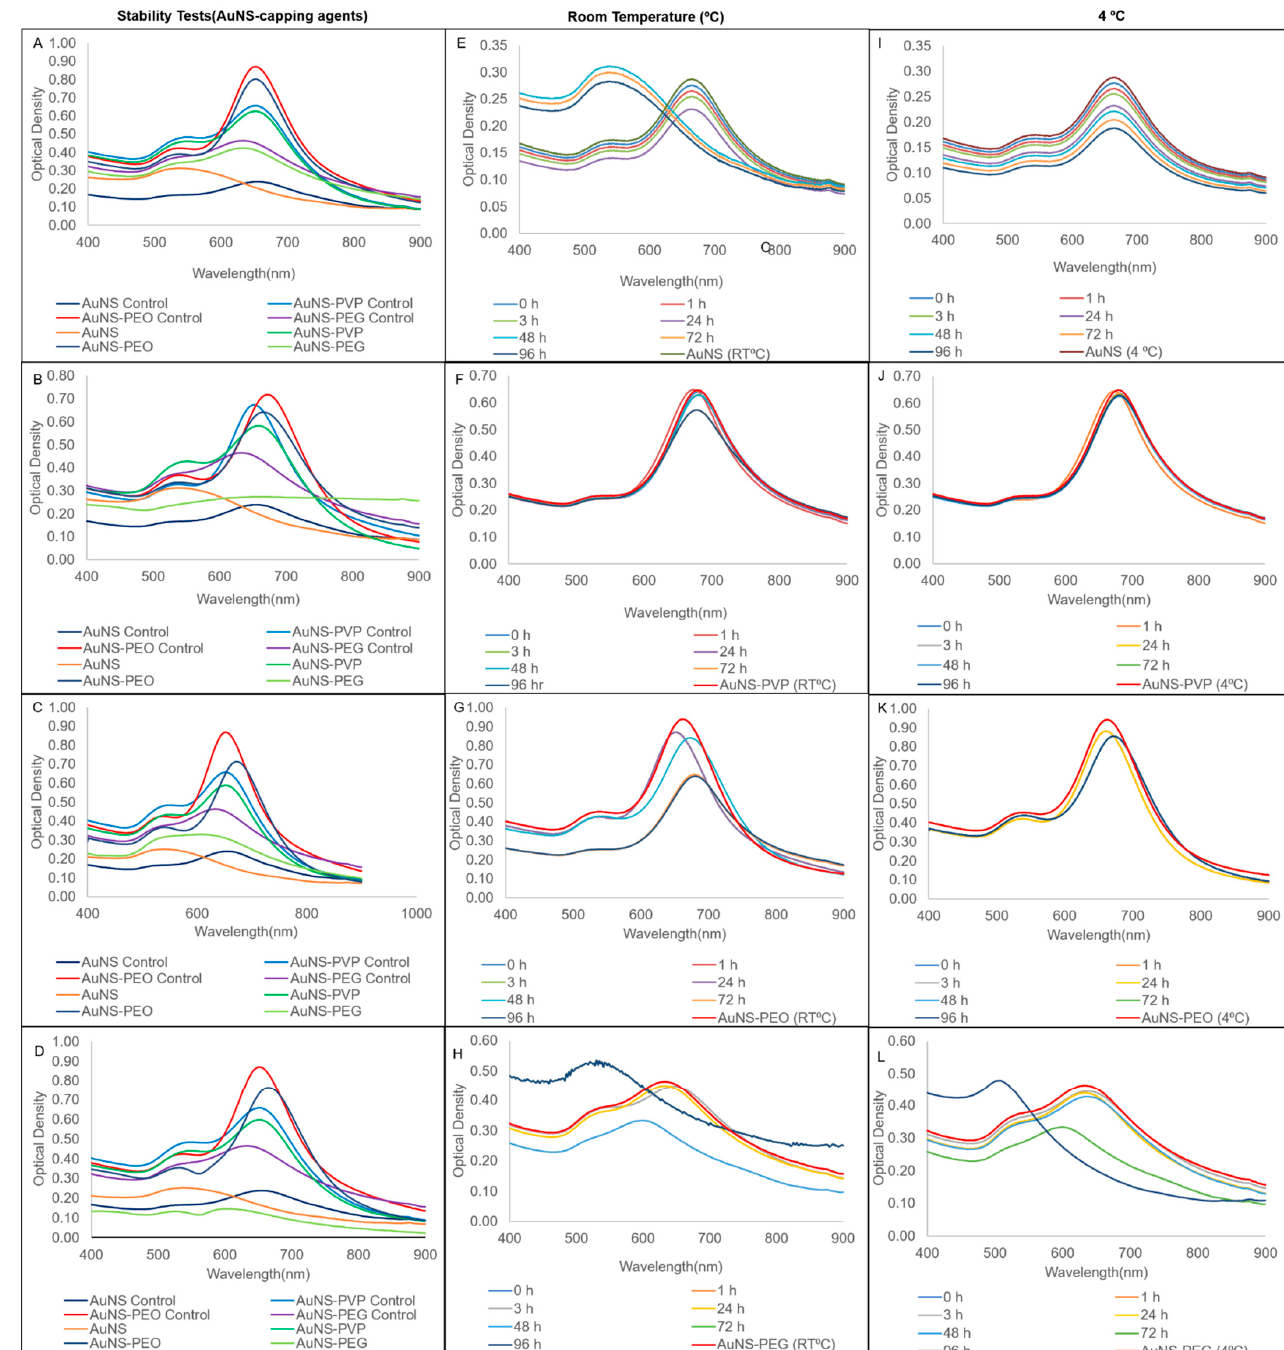
Figure 3. Comparison of UV-vis spectra of capped AuNS stability after 3 h of incubation in ( A ) salt; ( B ) urine; ( C ) serum; and ( D ) supplemented cell culture media. Storage stability UV-vis spectra at room temperature and 4 °C, respectively, for ( E , I ) AuNS; ( F , J ) AuNS-PVP; ( G , K ) AuNS-PEO; and ( H , L ) AuNS-PEG.